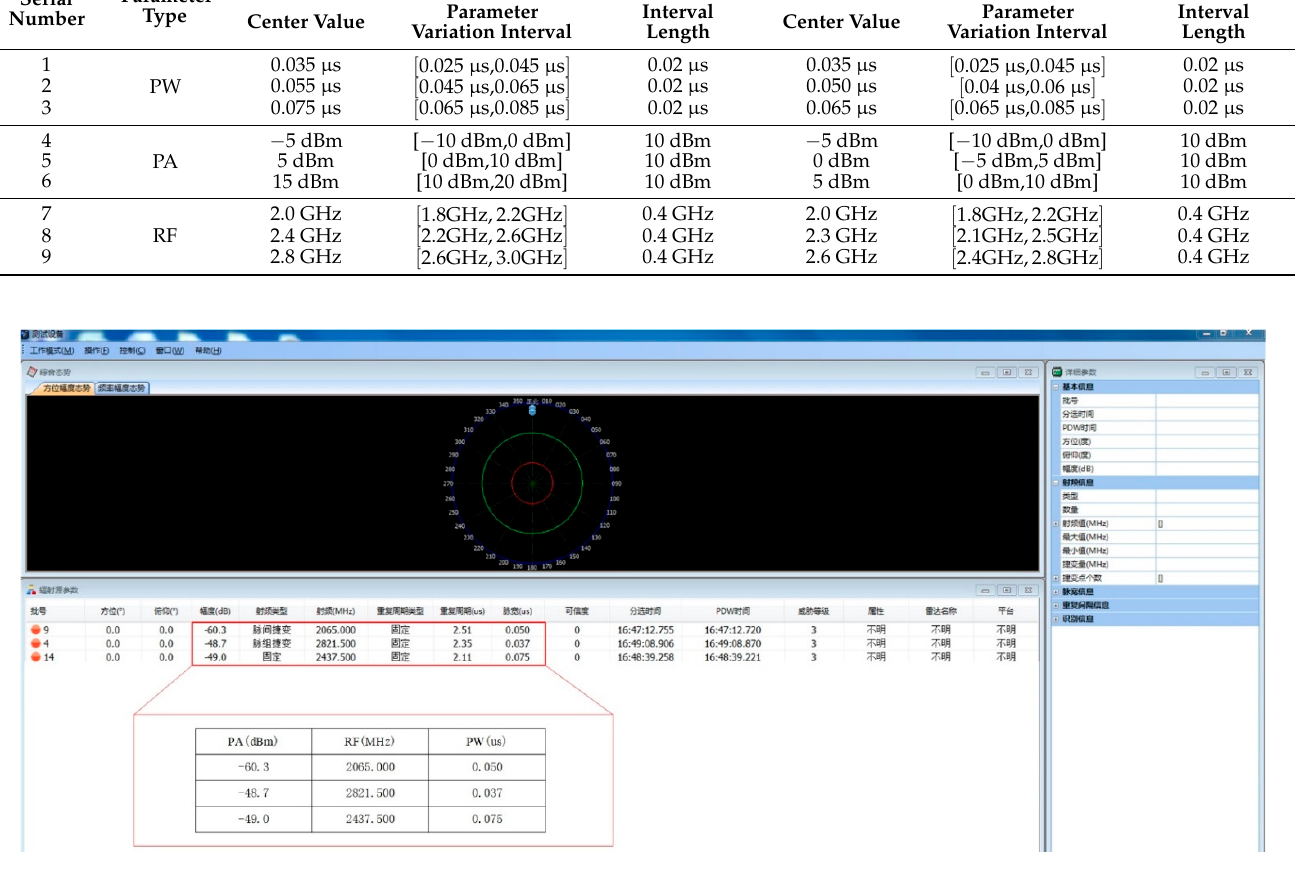
Figure 14. Sorting result diagram of the signal designed using the anti-clustering signal design method proposed in this paper.